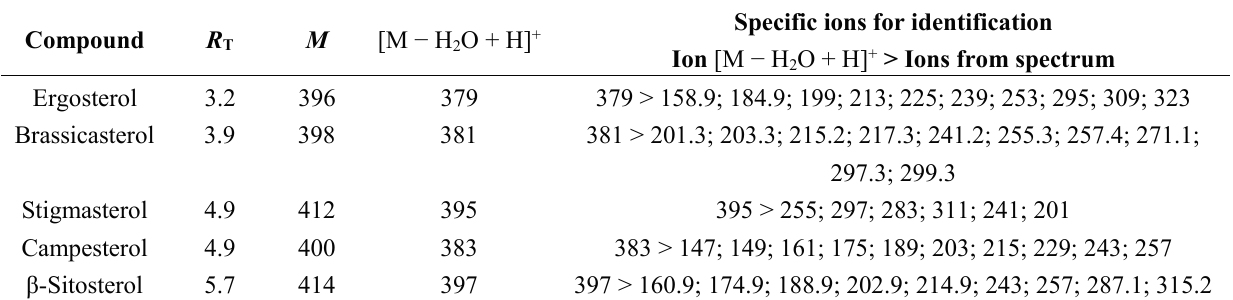
Table 4. Characteristic ions of standard sterols in full scan and specific ions used in quantification. Compound